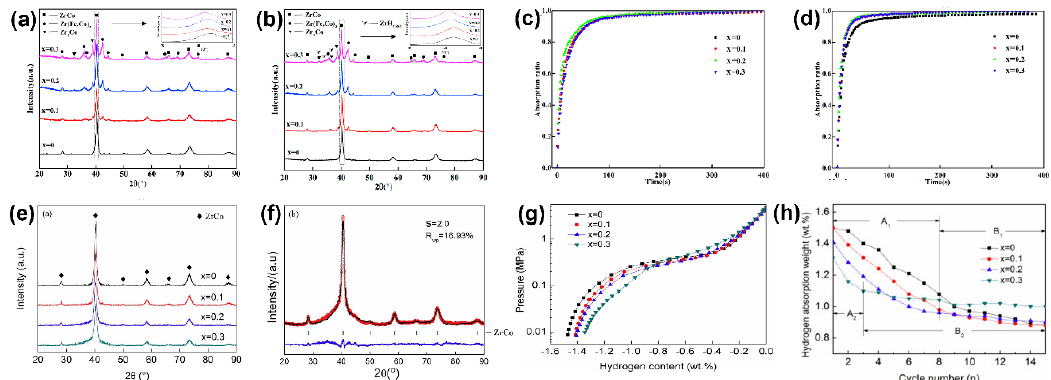
Figure 4. ( a ) XRD patterns of Zr 0.8 Ti 0.2 Co 1–x Fe x (x = 0–0.3) alloys after arc melting; ( b ) XRD patterns